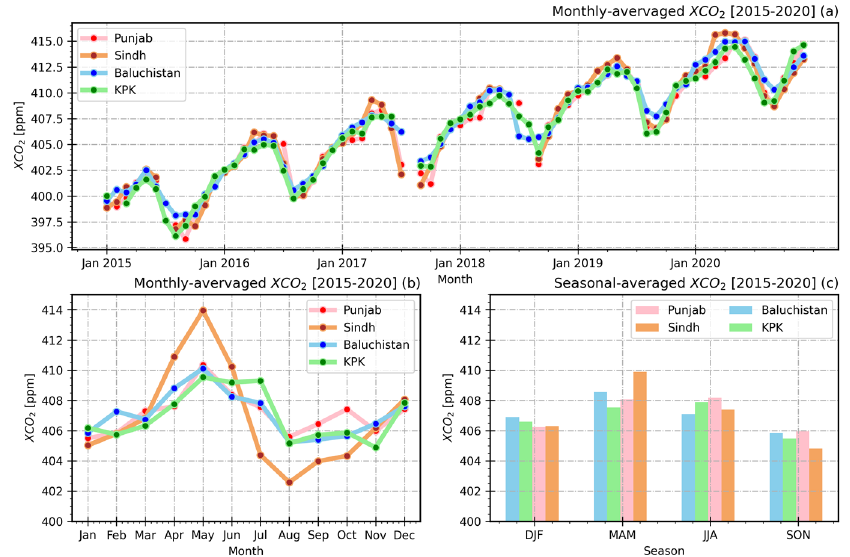
Figure 3. ( a ) Long-term time series, ( b ) monthly averaged, and ( c ) seasonal-averaged XCO 2 concen- trations in various administrative units (provinces) of Pakistan derived using OCO-2 XCO 2 retriev-